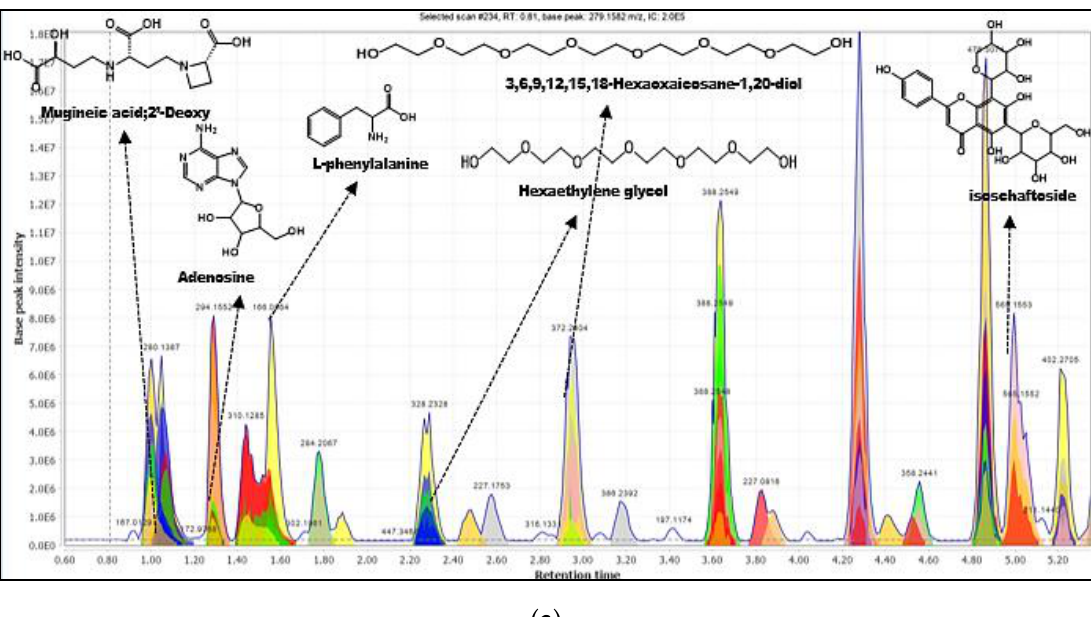
Figure 5. Mirror match of fragmentation of 2 with isoschaftoside by mzCloud spectral library.